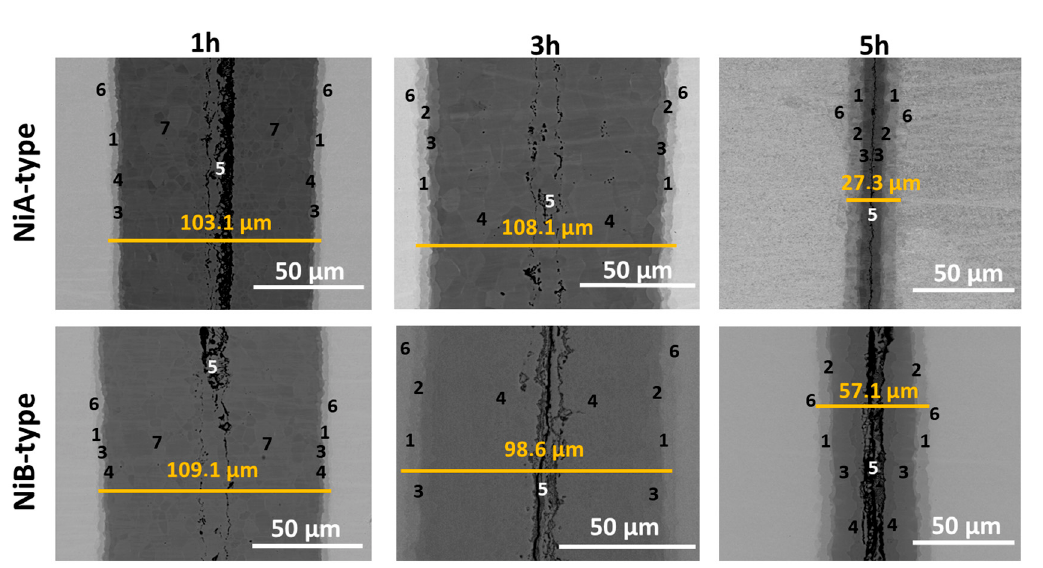
Figure 6. SEM micrographs of the cross-sectional view of a Ni/Al/Ni interconnections after 5 h of reaction time at 720 °C and EDS line-scan across this area for substrates of A-type ( a ) and B-type ( b ). A significant expansion of the annealing time to 20 and 72 h resulted in widening (Figure 7a) and disappearance (Figure 7b) of particular phases. After 20 h annealing at 720 °C the phases are broadened, however, the location of phases within the interconnection is the same as for samples annealed for 5 h using the substrates of B-type. The interconnection zone is symmetric. The AlNi deficient in nickel is slowly consumed, while the stoichiometric phase expands. 72 h is enough time to fully consume AlNi deficient in nickel and in the interconnection area only AlNi (51.6 at. % Ni), AlNi rich in nickel (60 at. % Ni) and Al 3 Ni (24.1 at. % Ni) are present. Phases of AlNi type are